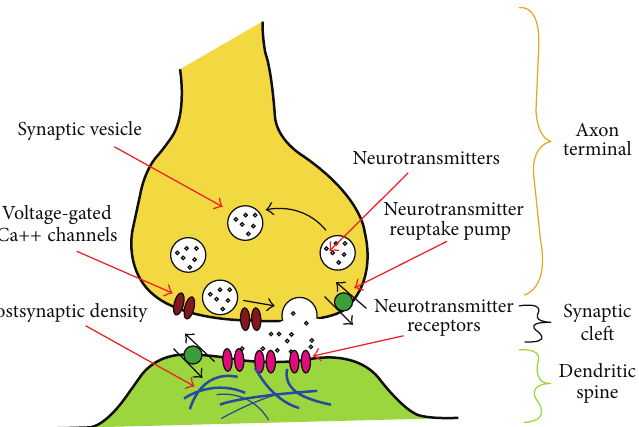
Figure 2: Signal transmission at a chemical synapse [21] (Source: Wikipedia, Surachit,